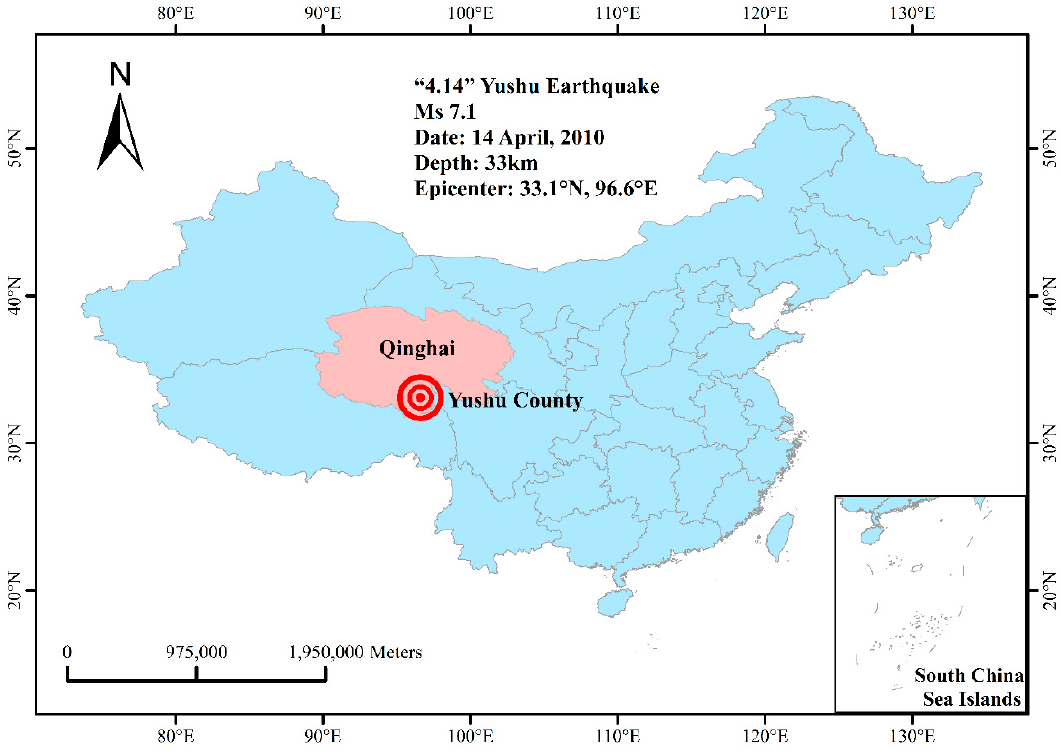
Figure 9. The location of Yushu County in China.